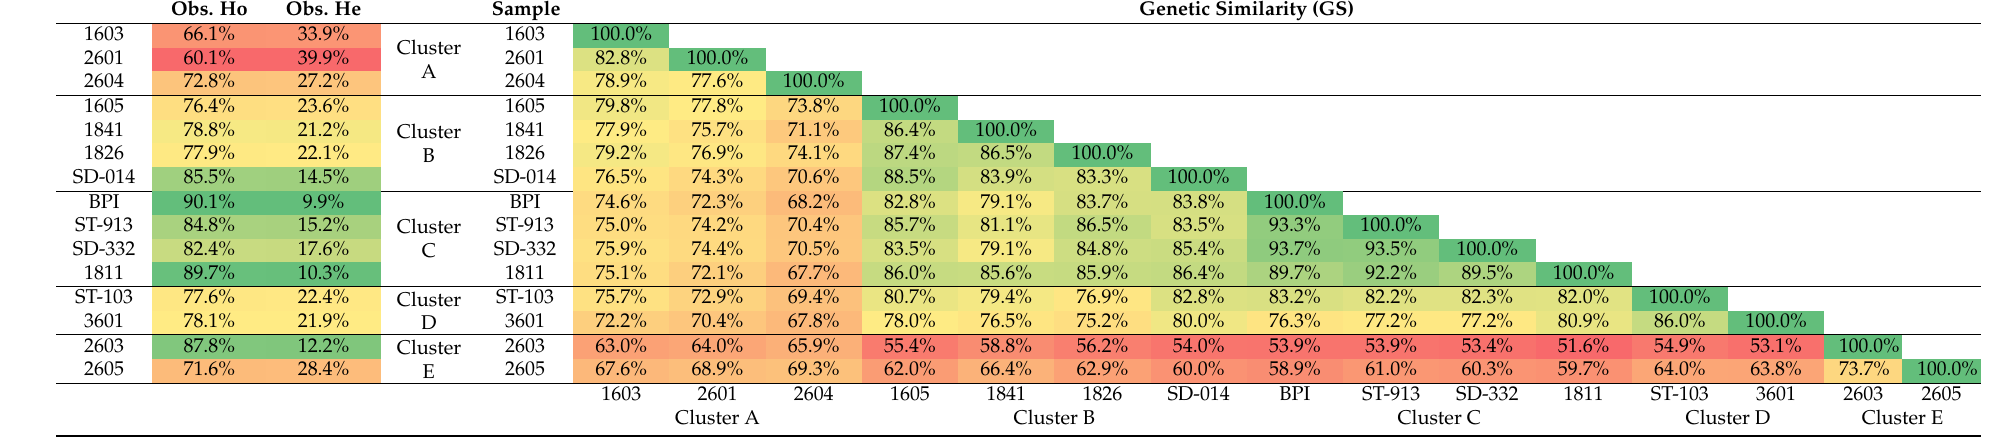
Table 2. Genetic Similarity matrix of 15 Lavandula individuals based on 16,228 SNPs with no missing data, and relative observed homozygosity (Obs. Ho) and heterozygosity (Obs. He). Obs. Ho Obs. He